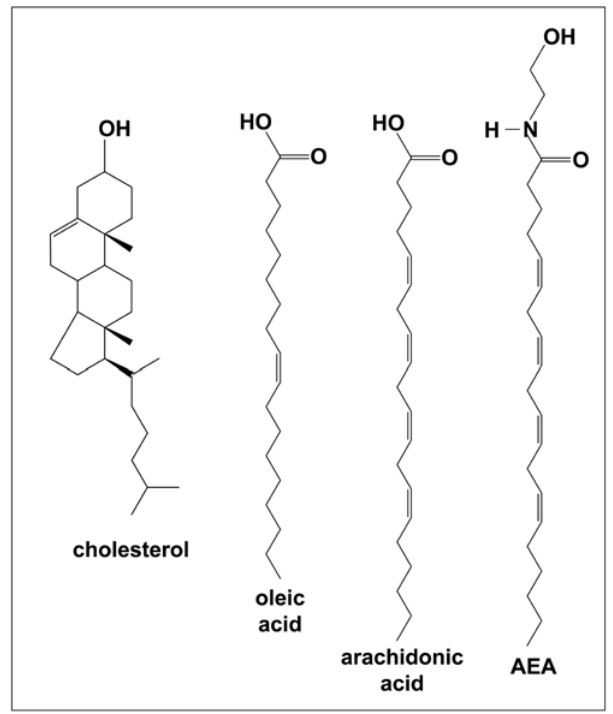
Figure 4. Chemical structures of cholesterol, anandamide and unsaturated fatty acids. Unsatutared fatty acids (arachidonic acid and oleic acid) are structurally related to anandamide. The interaction of cholesterol with these fatty acids, in comparison with anandamide, is shown in Figure 5.